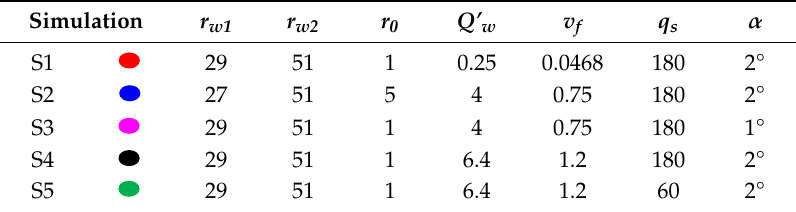
Table 1. Simulated grinding conditions.